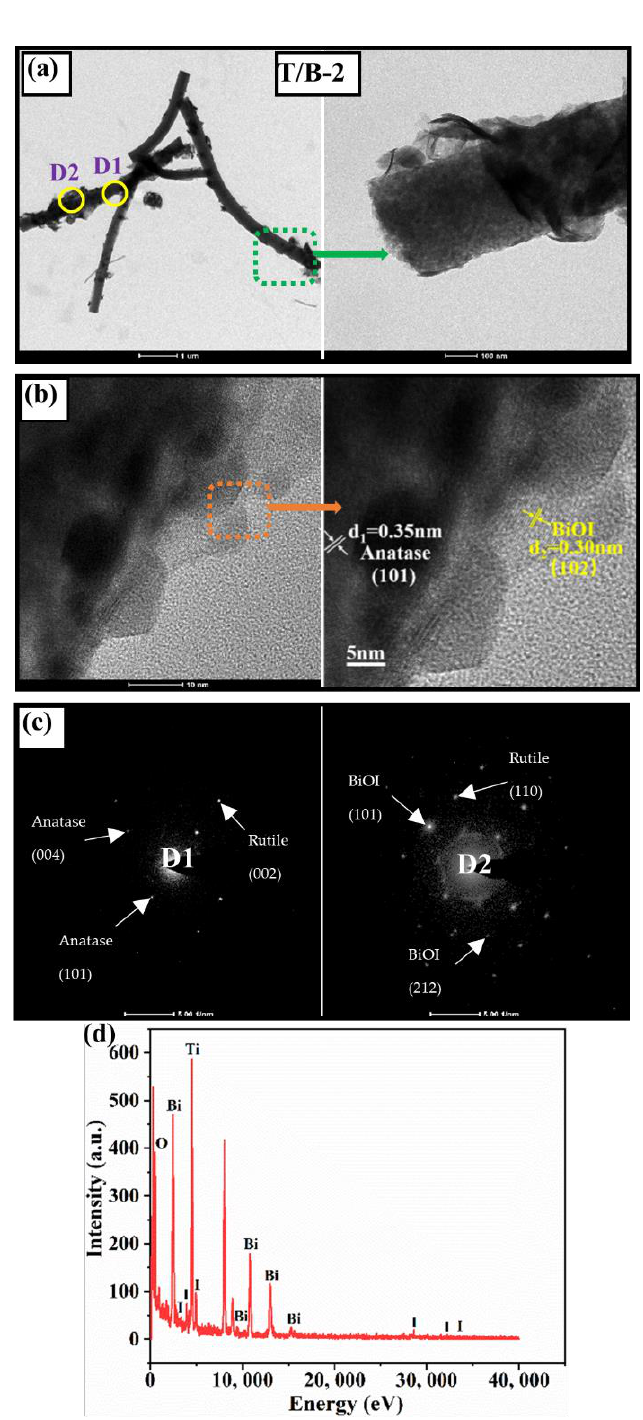
Figure 4. ( a ) TEM images of T/B-2 composite fiber and local magnification, ( b ) HRTEM image of T/B-2 and lattice labeling of BiOI and TiO 2 , ( d ) T/B-2 diffraction pattern calibration, ( c ) EDX map of T/B-2. The XRD patterns of all samples are shown in Figure 5. For the crystal structure of pure TiO 2 fiber, the anatase phase and a small amount of rutile phase are found, which is consistent with the TEM results. The anatase phase is mainly located around 25.8 ◦ , 37.8 ◦ , 48.0 ◦ , and 62.7 ◦ , corresponding to (101), (004), (200), and (204) crystals, respectively [34]. Rutile phase is mainly located at 27.4 ◦ , 36.1 ◦ , 54.3 ◦ , and 69.0 ◦ , corresponding to (110), (101), (211), and (301) crystal planes, respectively [35], and no diffraction peaks of other impurities are